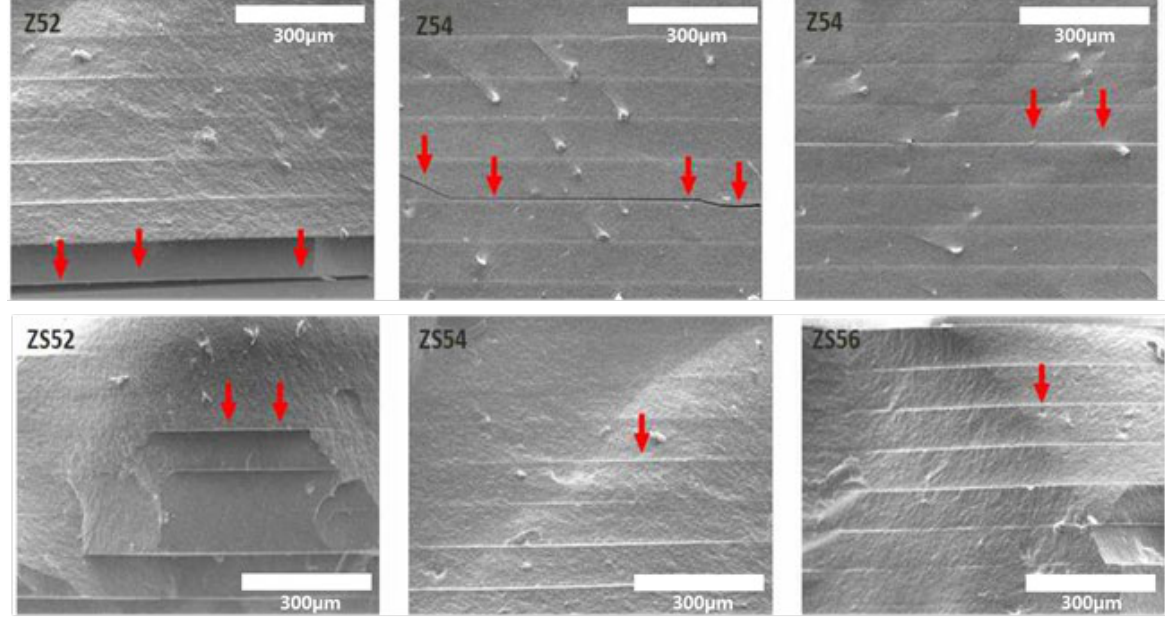
Figure 9. FE-SEM images of microstructure and layer-by-layer observation of the final sintered zir- conia specimen (Red arrows indicate microcracks and pores).